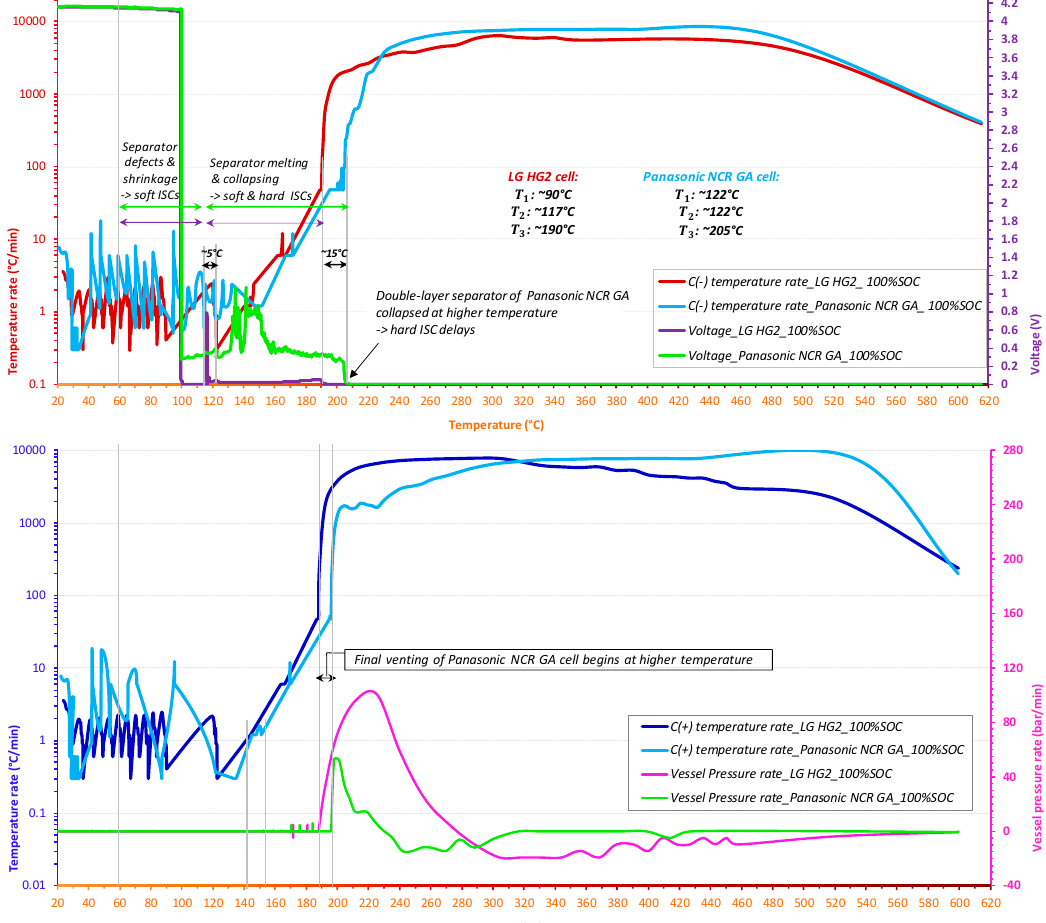
Figure 11. The C ( − ) temperature rate and cell voltage of LG HG2 and Panasonic NCR GA (at 100% SOC) versus C ( − ) temperature ( top ). Temperature rate of C (+) and vessel pressure rate of LG HG2 and Panasonic NCR GA (at 100% SOC) versus C (+) temperature ( bottom ).